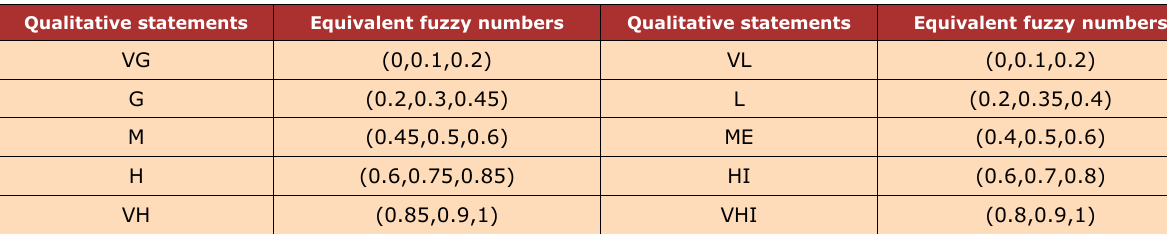
Table 4. Linguistic scale for importance